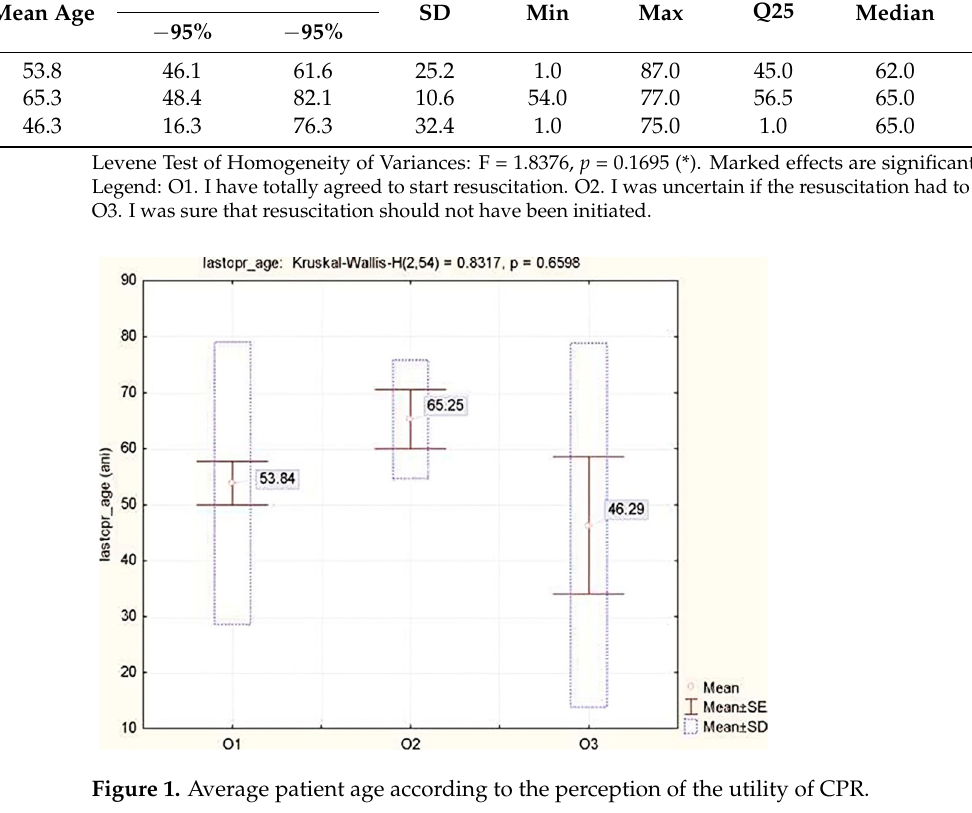
Figure 1. Average patient age according to the perception of the utility of CPR. The last CA recalled was confirmed by witnesses in 42.59% of cases. In 35.2% of cases, CPR was initiated before the arrival of the advanced resuscitation team. A shockable heart rhythm was identified by the team only in 22.2% of cases, with a higher significant value ( χ 2 = 11.0348, p = 0.0261) of cases with shockable rhythm at which nurses were present (25.9%) compared to those found by doctors (18.52%). The main cause of CA was identi- fied as cardiac in 57.41% of cases. The time interval of resuscitation lasted for an average of 37.07 ± 21.25 min, having a minimum value of 5 min and a maximum of 120 min. For 75% of patients, resuscitation took more than 25 min. The return of spontaneous circula- tion (ROSC) was obtained for 20.37% of cases, the declared discharge survival being 12.96%. A significant difference ( p = 0.6711) was not identified when obtaining ROSC in the case of doctors (22.2%) compared to that reported by assistants (18.52%). In the ana- lyzed group, no cases were identified for which there were restrictions on therapy (will, advanced directive, a mention “not to resuscitate”). The impressions regarding the phys- ical condition of the patient did not have significant differences ( χ 2 = 4.3279, p = 0.3634) between doctors and nurses. For 64.81% of patients, the impression was bad or deficient and only in 27.78% of cases was it reasonable or good. In 92.59% of cases, the respondents appreciated that the resuscitation presented a good technical quality. This opinion was shared both by doctors and nurses, without significant differences ( χ 2 = 3.1409, p = 0.5345). Only 3.5% of the respondents were not satisfied with the technical quality of resuscitation. We identified a significant association ( χ 2 = 6.9136, p = 0.01405) between ROSC and the perception of the utility of initiating resuscitation. Thus, it was found that in situations in which medical staff were sure that it was necessary to initiate resuscitation, the return of spontaneous circulation was noted in 23.36% of cases, and in 25% of cases where there was a certain insecurity. These results are shown in Table 6. Table 6. The perception of the utility of the initiation of CPR vs. ROSC . Opinion on Necessity of CPR